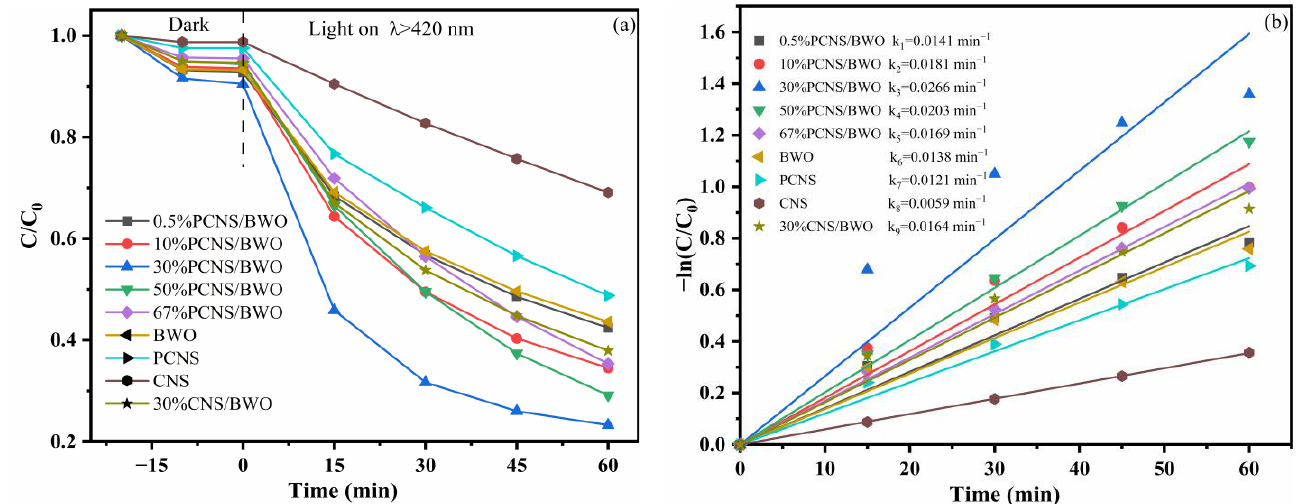
Figure 9. ( a ) Degradation curves of TC-HCl and ( b ) pseudo-first-order reaction kinetics of catalysis under visible light irradiation.